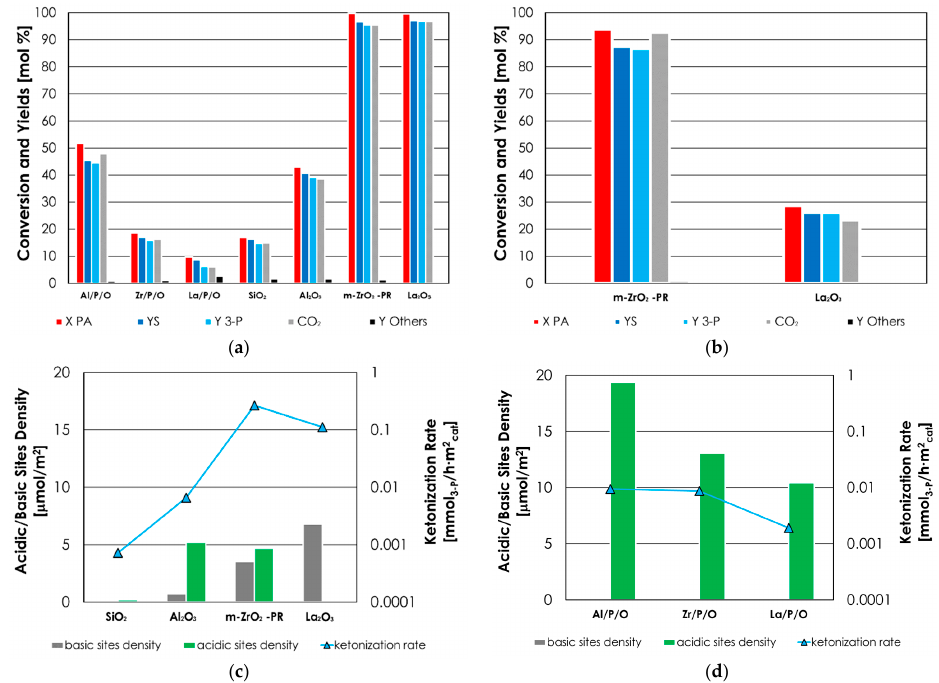
Figure 2. ( a ) Catalytic activity of metal oxides and phosphates for the ketonization of PA to 3-P. Reaction conditions: temperature = 350 °C, PA = 6 mol % in N 2 , time factor = W/F = 0.8 s*g/mL. ( b ) Catalytic activity of m -ZrO 2 -PR and La 2 O 3 for the ketonization of PA to 3-P. Reaction conditions: same as ( a ) but with time factor = W/F = 0.2 s*g/mL. Symbols: propionic acid conversion (X PA, red), sum of yields (YS, blue), 3-pentanone yield (Y 3-P, light blue); CO 2 yield (Y CO 2 , gray); by-products sum of yields (Y Others, black). ( c , d ) Correlation between the desorbed NH 3 (green) and CO 2 (gray) and the intrinsic rate of PA ketonization of metal oxides ( c ) and metal phosphates ( d ).